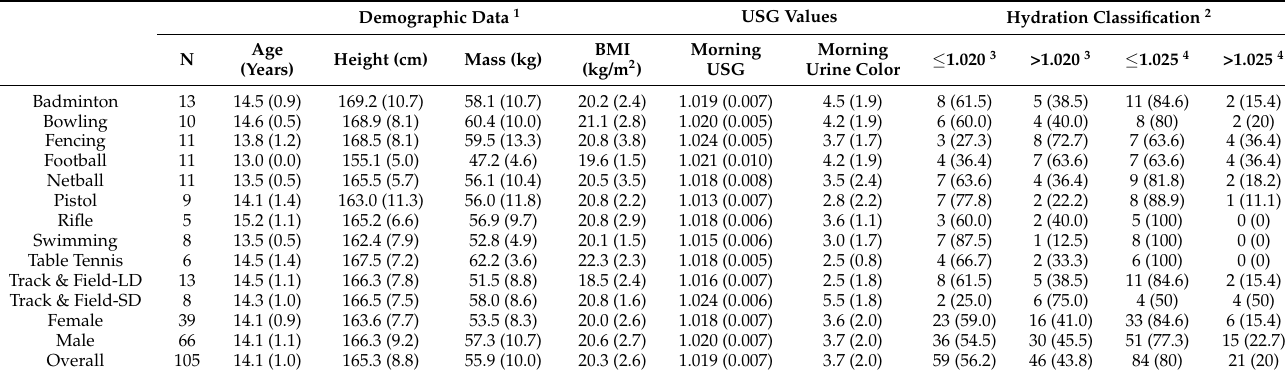
Table 1. Participant demographic and morning hydration